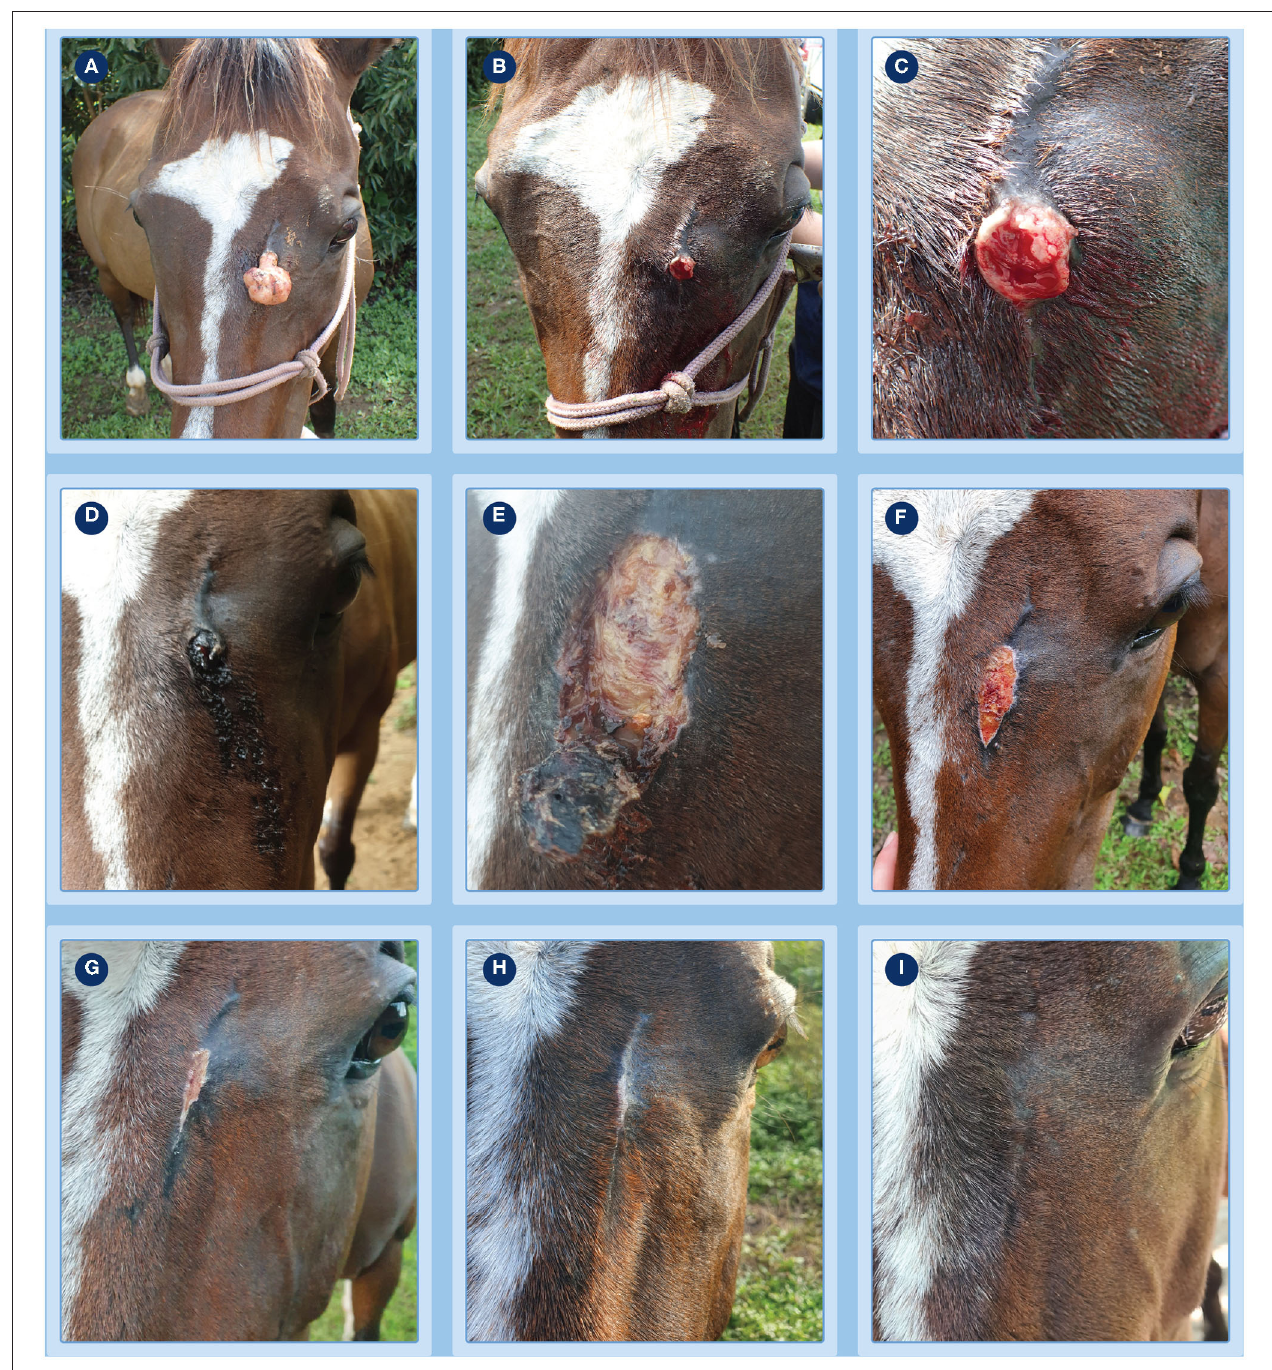
FIGURE 1 | Progression of clinical response of a fibroblastic sarcoids to treatment with tigilanol tiglate. (A) the pedunculate sarcoid prior to treatment; (B,C) treatment site after pedicle had been surgically excised to allow measurement of sarcoid base for calculation of dosing and immediately prior to injection with tigilanol tiglate (D) the development of bruising and haemorrhagic necrosis by 24h after injection; (E) tumor slough at day 6; (F–H) progression of healing at days 15, 27, and 36; (I) no evidence of sarcoid recurrence at the treatment site by day